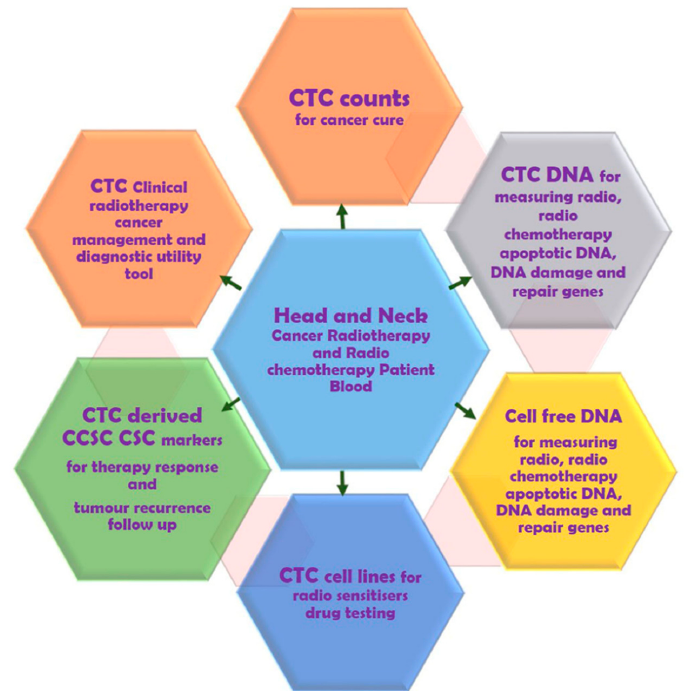
Figure 3. Potential of head and neck circulating tumour cell research in radiation oncology.